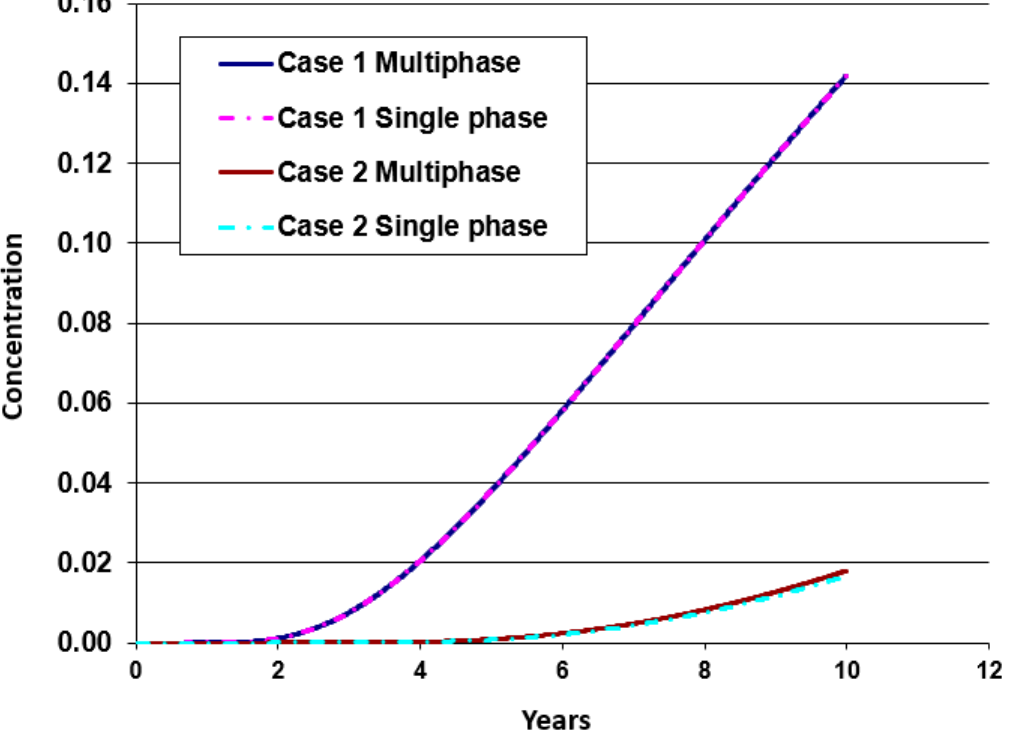
Figure 2. Comparison of two-phase tritium transport to the Smiles et al. (1995) [32] single-phase equivalent formulation, all simulations run with FEHM.